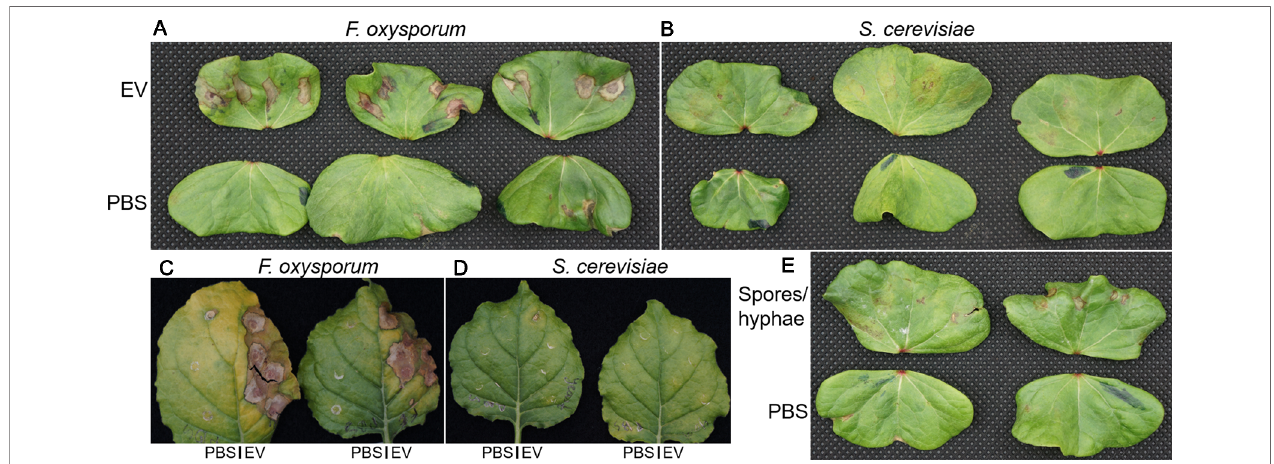
FIGURE 3 | The effect of fungal EVs on cotton cotyledons. EVs were puri fi ed from F. oxysporum f. sp. vasinfectum and S. cerevisiae and diluted to a protein concentration of 0.1 µg/ml in PBS. (A , B) Paired cotyledons were in fi ltrated at four points with the EV solution and PBS control. After 5 days incubation, the cotyledons were removed from the plants and imaged. Cotyledons in fi ltrated with EVs from F. oxysporum f. sp. vasinfectum (A) had discolored/brown spots around the sites of in fi ltration, whereas the cotyledons in fi ltrated with EVs from S. cerevisiae (B) only had mild discoloration or no response. Cotyledons in fi ltrated with PBS had no observable effect (the brown spot on the third cotyledon in the F. oxysporum panel (A) is due to a pinch point as a result of a fold in the leaf and not in fi ltration). (C , D) N. benthamiana leaves were in fi ltrated with EVs at multiple points on the right half and PBS on the left. After 5 days the leaves were removed from the plants and imaged. Leaf halves in fi ltrated with EVs from F. oxysporum f. sp. vasinfectum (C) showed substantial discoloration around the sites of in fi ltration, whereas the half in fi ltrated with PBS had no discoloration. Leaf halves in fi ltrated with EVs from S. cerevisiae (D) appeared similar to the corresponding PBS in fi ltrated leave halves. In fi ltration of cotton cotyledons with resuspended F. oxysporum f. sp. vasinfectum spores and hyphae (E) led to the formation of very small discolored spots at the sites of in fi ltration, but they were much smaller than those observed with EVs. Images are representative of three independent